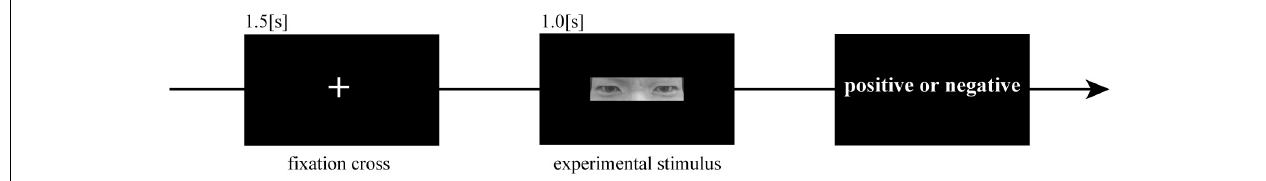
FIGURE 1 | Timeline of the trial. The experimental stimulus was displayed for 1.0 s, after which a fixation cross appeared for 1.5 s. The next trial began after participants provided their answers.